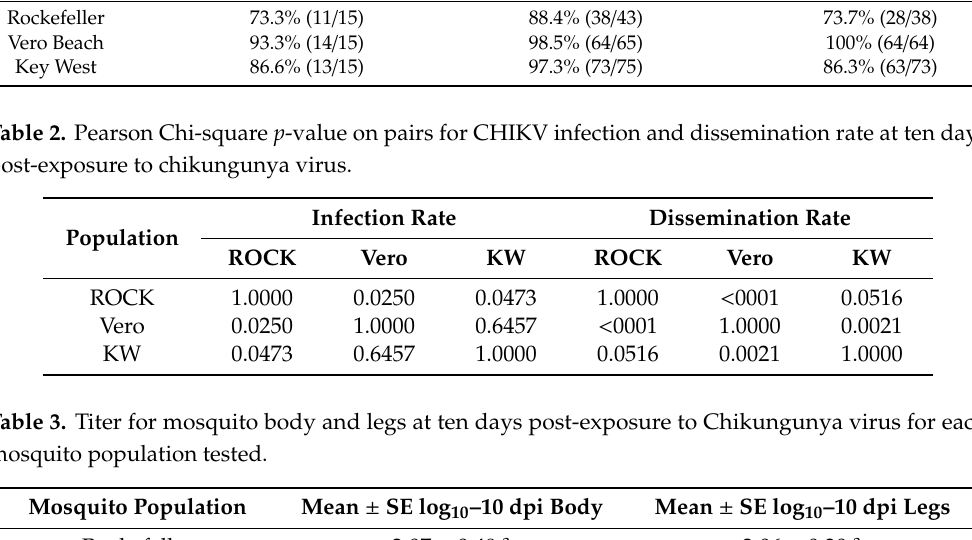
Table 1. InfectionanddisseminationrateresultsforChikungunyavirusinfectioninthreedifferentpopulations. Mosquito Population